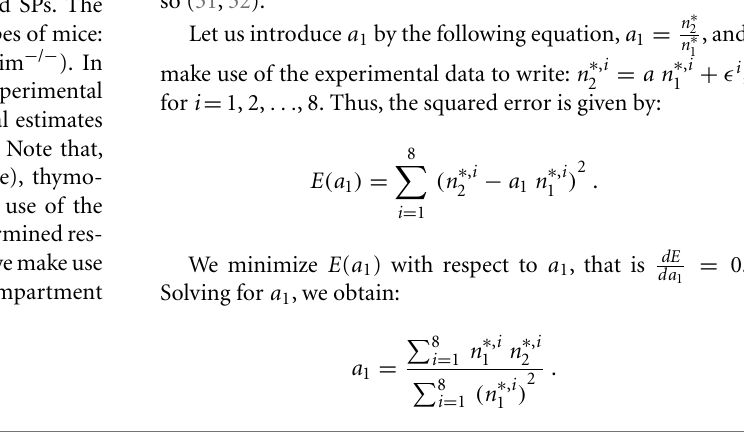
Table 1 | Experimental steady state thymocyte cell counts for the wild type pre-DP, post-DP, CD4 SP, and CD8 SP populations. Mouse n ∗ (pre-DP) 1